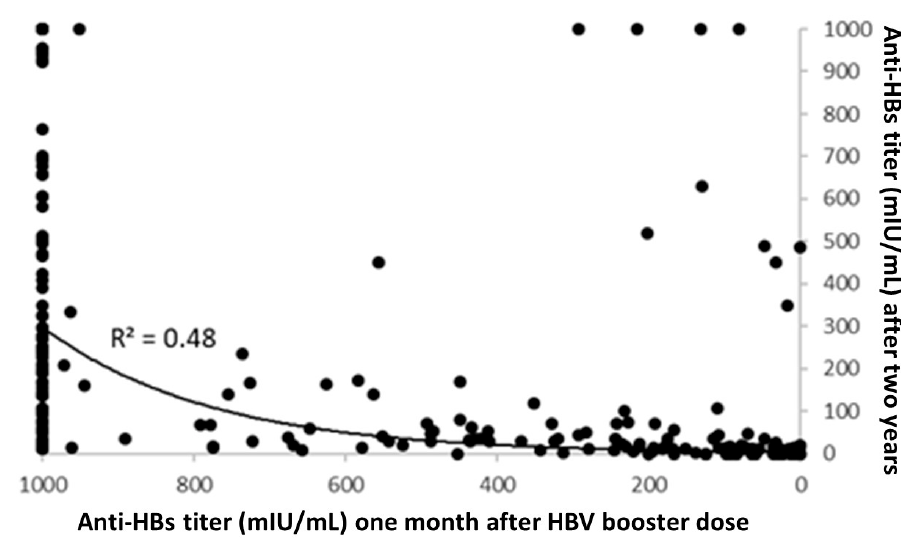
Figure 2. Correlation analysis between anti-HBs titers one month after hepatitis B virus (HBV) booster